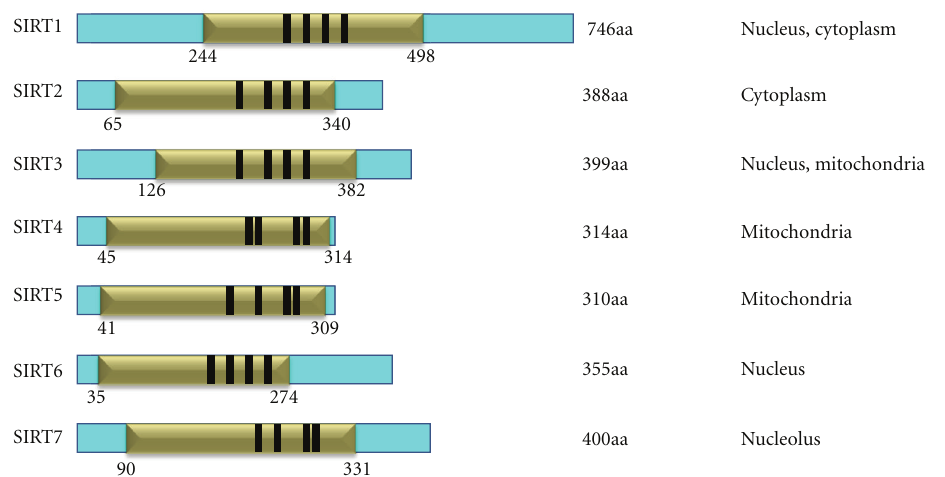
Figure 1: Schematic representation of human sirtuins family members 1–7, NAD-dependent catalytic domain (gold) (NAD-binding pocket), zinc-binding domain (black), and their intracellular localization.